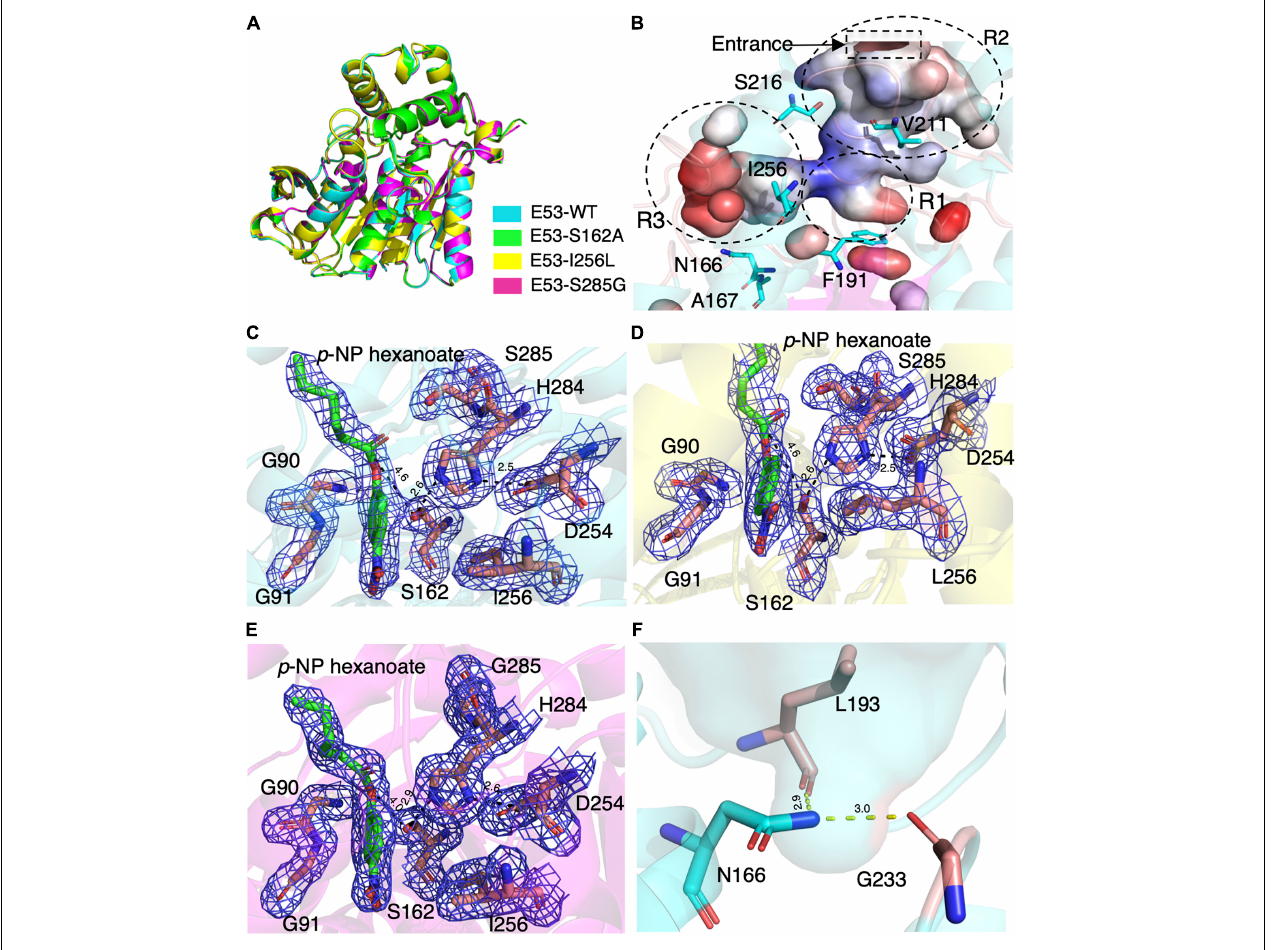
FIGURE 3 | The crystal structures of E53 and its variants. (A) The superimposed global structure of E53 (cyan), S162A (green), I256L (yellow), and S285G (magenta). (B) The catalytic pocket of E53. The catalytic pocket was divided into R1, R2, and R3 regions. The mutated residues were shown as stick models. Electrostatic surface is shown: red color represented negative potential and blue color represented positive potential. (C) The C6 substrate and the catalytic triad of WT E53. (D) The C6 substrate and the catalytic triad of I256L. (E) The C6 substrate and the catalytic triad of S285G. All the electron density maps were contoured to 1.0 σ at the 2Fo-Fc map. (F) The N166 and its interaction with L193 and